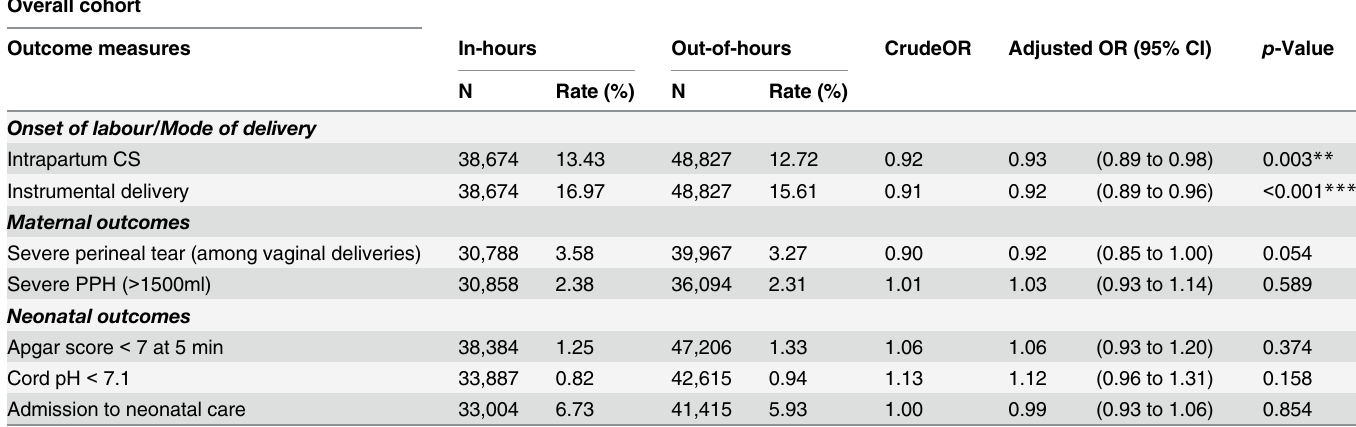
Table 2. Crude and adjusted odds ratios for adverse perinatal outcomes, comparing in-hours and out-of-hours.